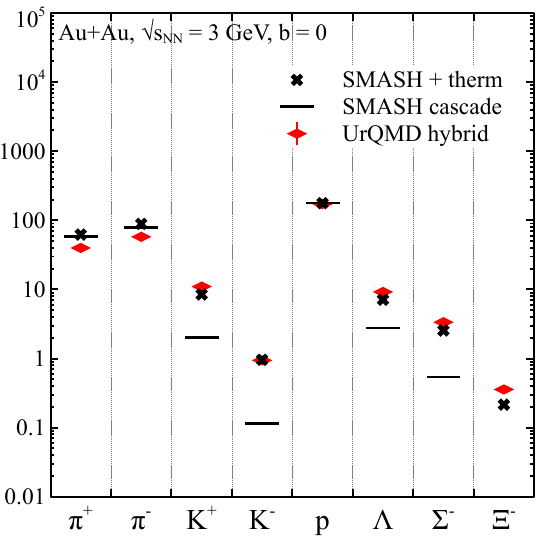
Figure 3. SMASH with and without forced canonical thermalization compared to a UrQMD hybrid model [15]. The energy density threshold for thermalization in SMASH ( (cid:101) th ) and particlization in the hybrid approach was set to twice the nuclear ground-state energy density. The strangeness enhancement due to the forced thermalization is comparable to the hybrid